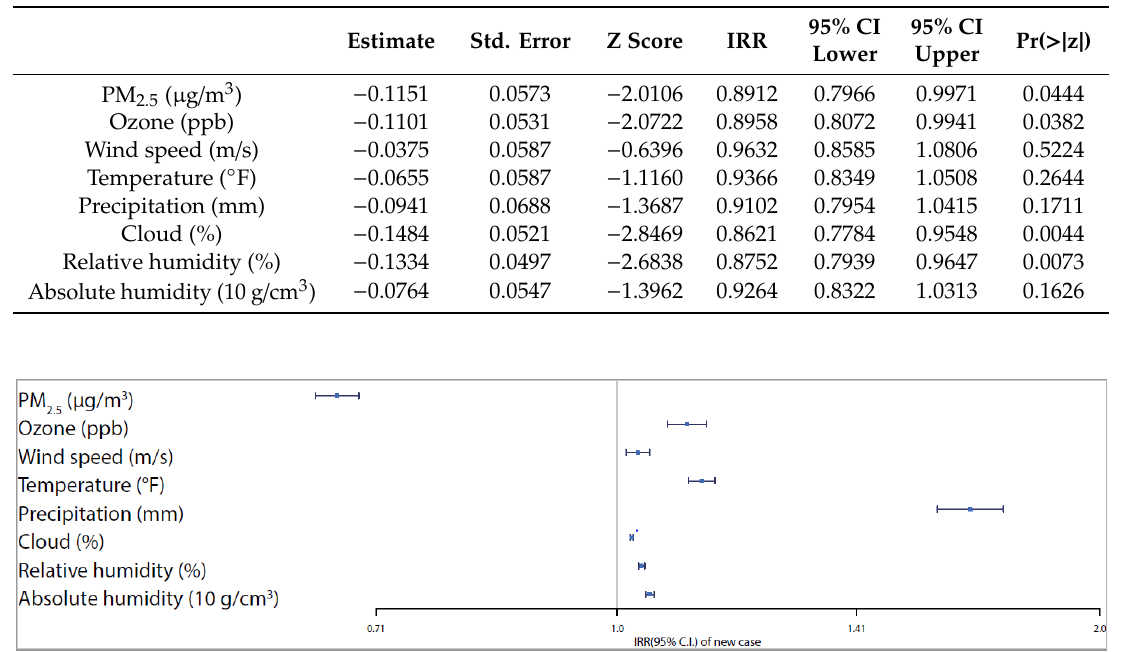
Table 4. Single-predictor regression model results for the relation among the moving average of lag 0–21 days of each environmental predictors and new COVID-19 deaths adjusted by trend and lag 1-day values of deaths.